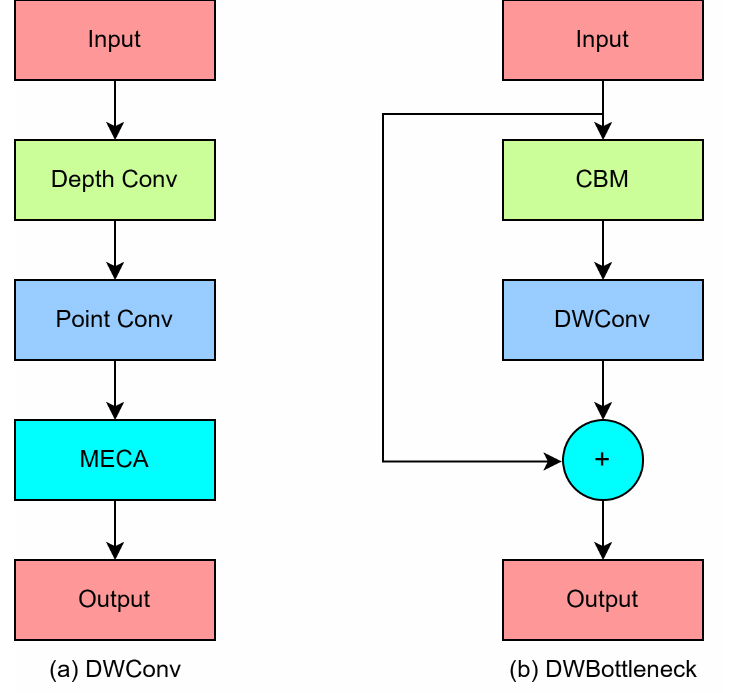
Figure 3. ( a ) DWConv consists of depth convolution, point-by-point convolution, and MECA atten- tion, and ( b ) DWBottleneck consists of CBM and